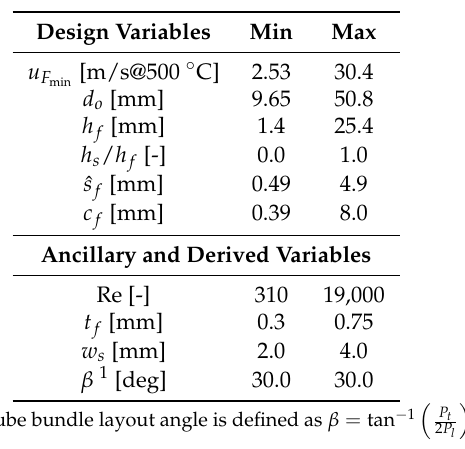
Figure 1. Process for correlation development, testing and benchmarking. Green boxes indicate where CFD simulations are employed. Table 2. Considered design space for compact fin-tube bundles. Ancillary variables are adjusted to achieve a reasonable number of segments per fin revolution and a representative fin efficiency. Geometric parameters are shown in Figure